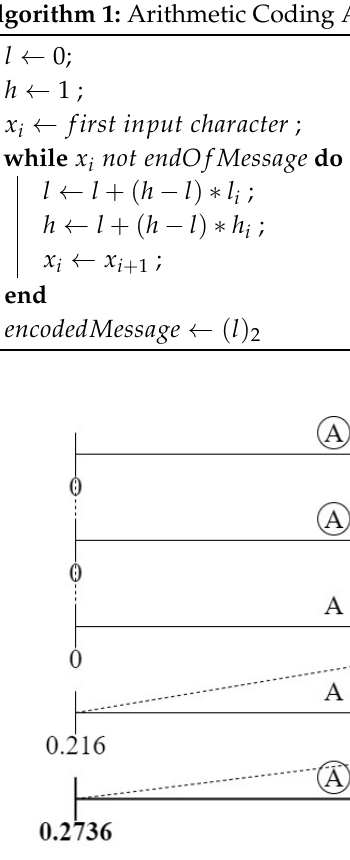
Figure 1. Arithmetic encoding the word